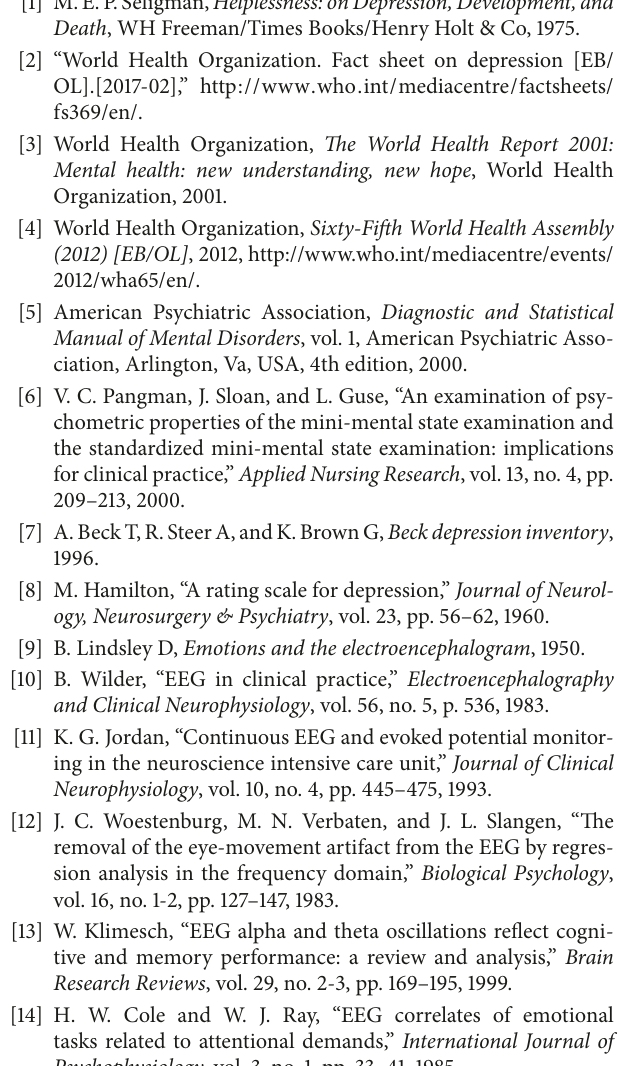
performance features of the four datasets, thereby suggesting a robust connection between the power of theta wave and depression; this could be used as a valid characteristic feature in the detection of